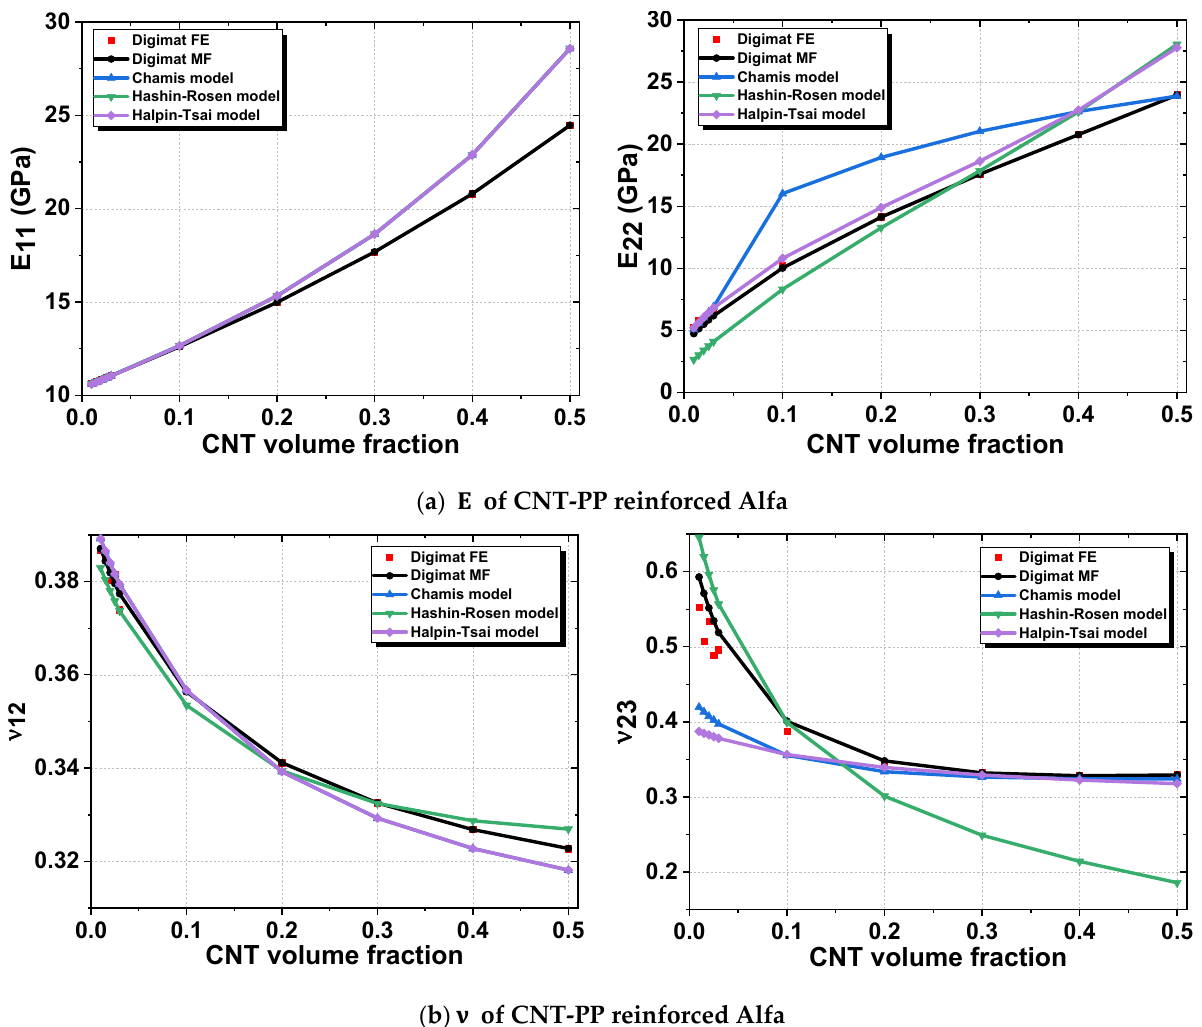
Figure 11. Elastic properties of CNT-PP matrix reinforced by alfa aligned fiber (50 vol%) vs. CNT volume fraction. ( a ) Young’s modulus E . ( b ) Poisson’s ratio ν .